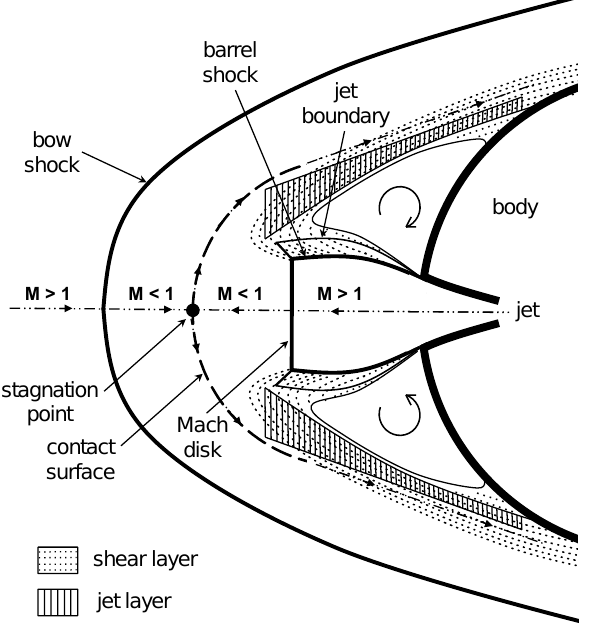
Figure 1. Characteristic flow field for supersonic retropropulsion (taken from [8]).